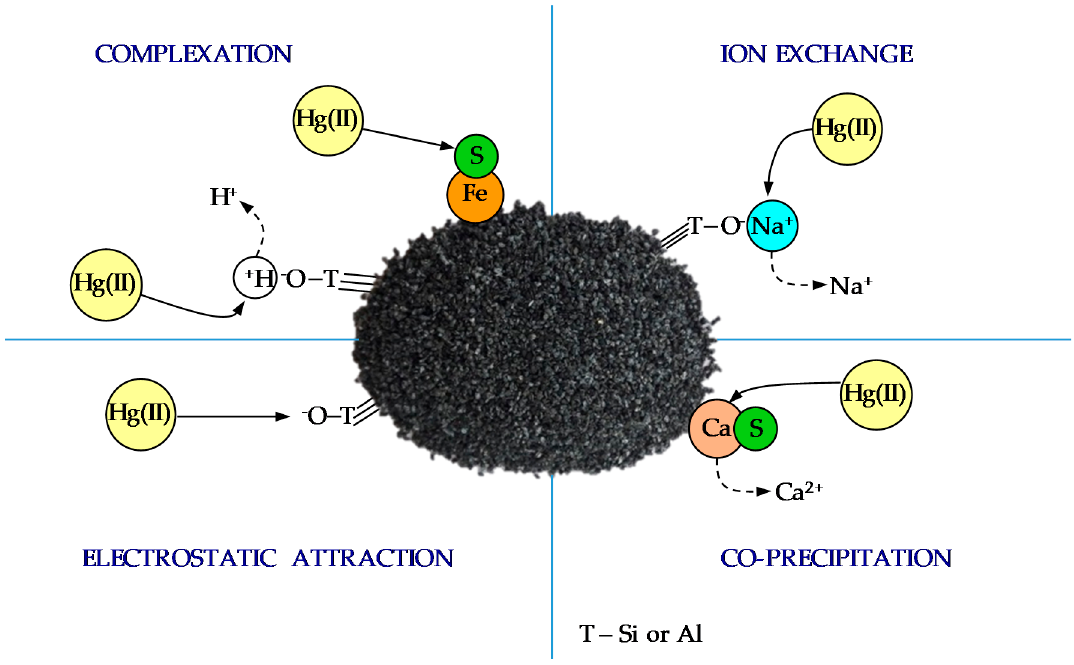
Figure 19. Illustration of proposed sorption mechanism of Hg(II) species onto SZ.